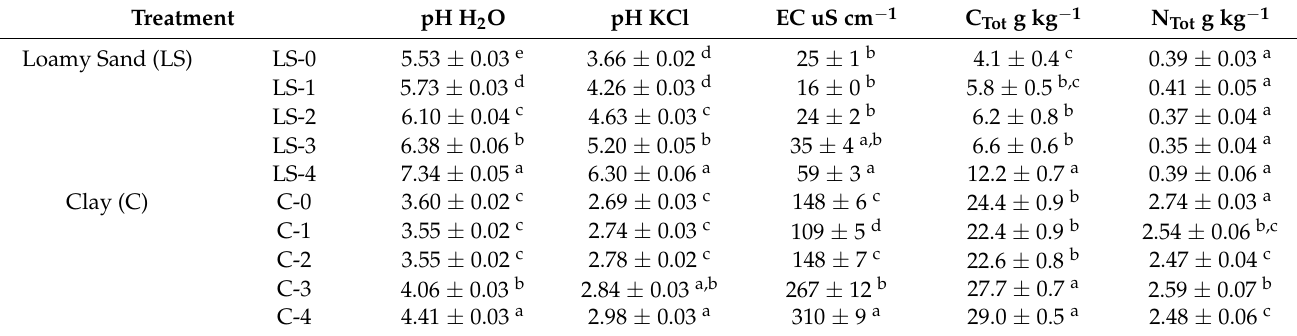
The mean values marked with the same letters in superscript do not differ significantly at p < 0.05. EC—electrical conductivity, C Tot —total carbon, N Tot —total nitrogen content.